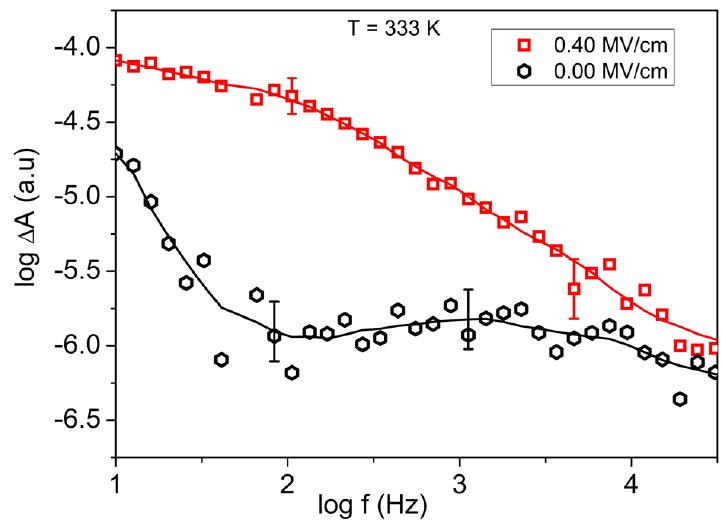
Figure 6. Example of the data analysis. The modulated signal (second harmonic) measured with the lock-in amplifier is displayed in dependence of the frequency of the external electric field. As spacer, a PET foil of ~3 μ m thickness was used. This results for an applied voltage of +/ − 120 V in an electric field strength ~+/ − 0.4 MV/cm with a large uncertainty because the absolute sample thickness cannot be measured with sub- µ m accuracy. The data are averaged, and for the resulting curve (solid lines), uncertainty bars are indicated. By division, the orientation polarization spectra are obtained as shown in Figure 7.